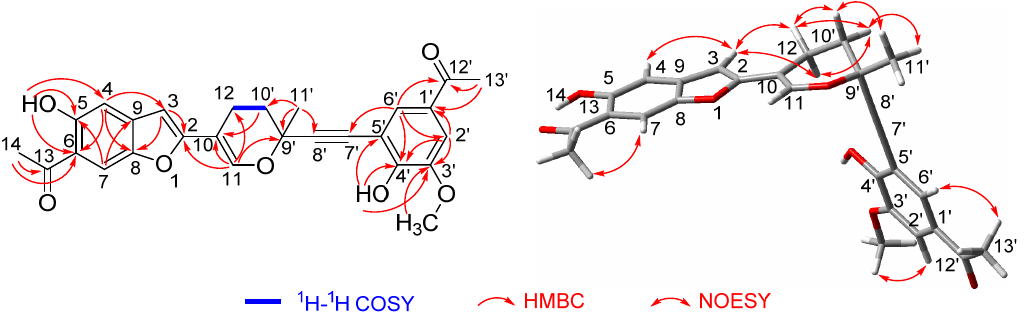
Figure 6. Key 2D NMR correlations for 5 . Compound 14 was obtained as colorless amorphous powder. Based on the [M+H] + peak at m / z 291.1231 in its HRFABMS, its molecular formula was determined to be C 16 H 18 O 5 . The 1 H and 13 C NMR data (Table 3) were similar to those of known compound 13 [25]; however, the appearance of signals attributed to a propionyl group [ δ H 2.31 (2H, q, 7.6 Hz), 1.12 (1H, t, 7.6 Hz); δ C 174.1, 27.7, 9.0] in the NMR spectrum of 14 instead of those attributed to an isobutanoyl group in 13 suggested that 14 was a 3-propionyloxy analog of 13 (Figure 7). The 2,3- cis nature was indicated by J 2,3 (6.4 Hz) [20,21] and the NOE correlation between H-2 and H-3 (Figure 8). Therefore, the structure of compound 14 was determined as shown in Figure 8. Compound 17 was obtained as yellowish amorphous powder. Its molecular formula Table 3. 1 H (500 MHz) and 13 C (126 MHz) NMR data of 14 , 17 , and 21 in CDCl 3 was determined to be C 18 H 20 O 6 by the [M + Na] + peak at m / z 355.1160 in its HRFABMS.